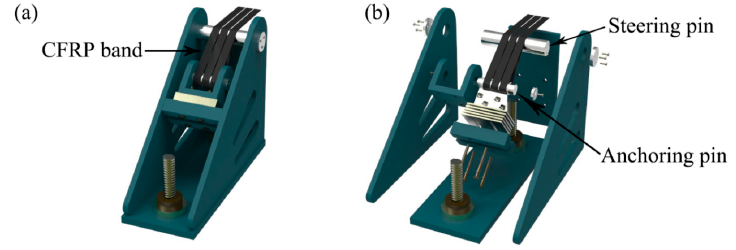
Figure 26. Pin-loaded anchorage system, ( a ) assembled view and ( b ) exploded view.